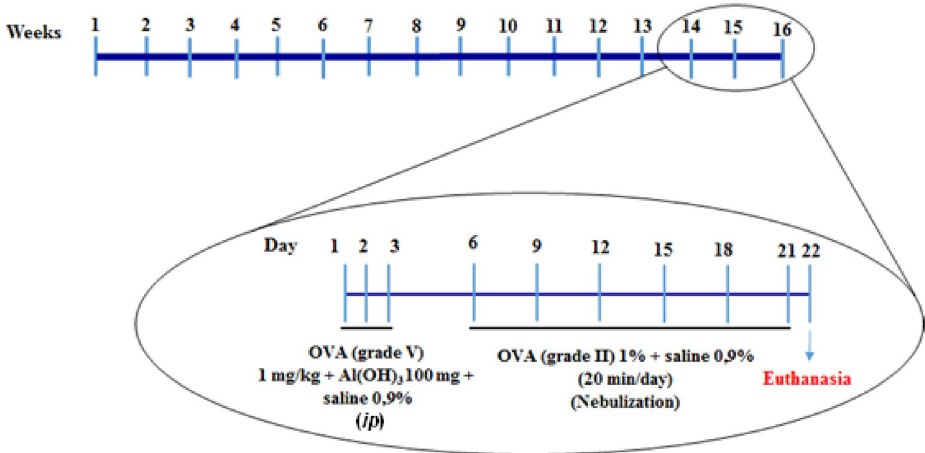
Figure 13. Flowchart and timeline of the study design for asthma. OVA ovalbumin, Al ( OH ) 3 aluminum hydroxide, ip